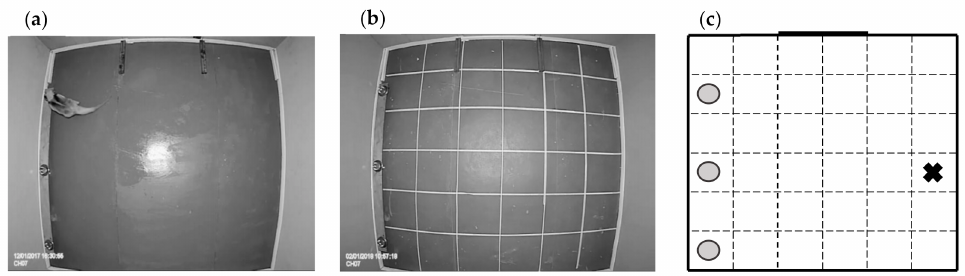
Figure 2. Evaluation room used to study lesser anteaters’ behavior in response to termites and ants: ( a ) a video image of the room taken with the camera used to video record activities during the behavioral evaluation, the feeders, and an anteater in contact with one feeder. The position of each food type was randomized during each session. The camera was located on the ceiling; ( b ) prior to the first behavioral evaluation, we delimited zones in the room with adhesive tape to record activities on the videos. Tapes were removed before performing the evaluations; ( c ) a diagram of the evaluation room based on lines on the floor. Each video was filtered by this diagram on the monitor, and we analyzed the activities of lesser anteater. “x” means the space where the lesser anteater was released with its four legs contacting the ground in the evaluation room, and “circles” means